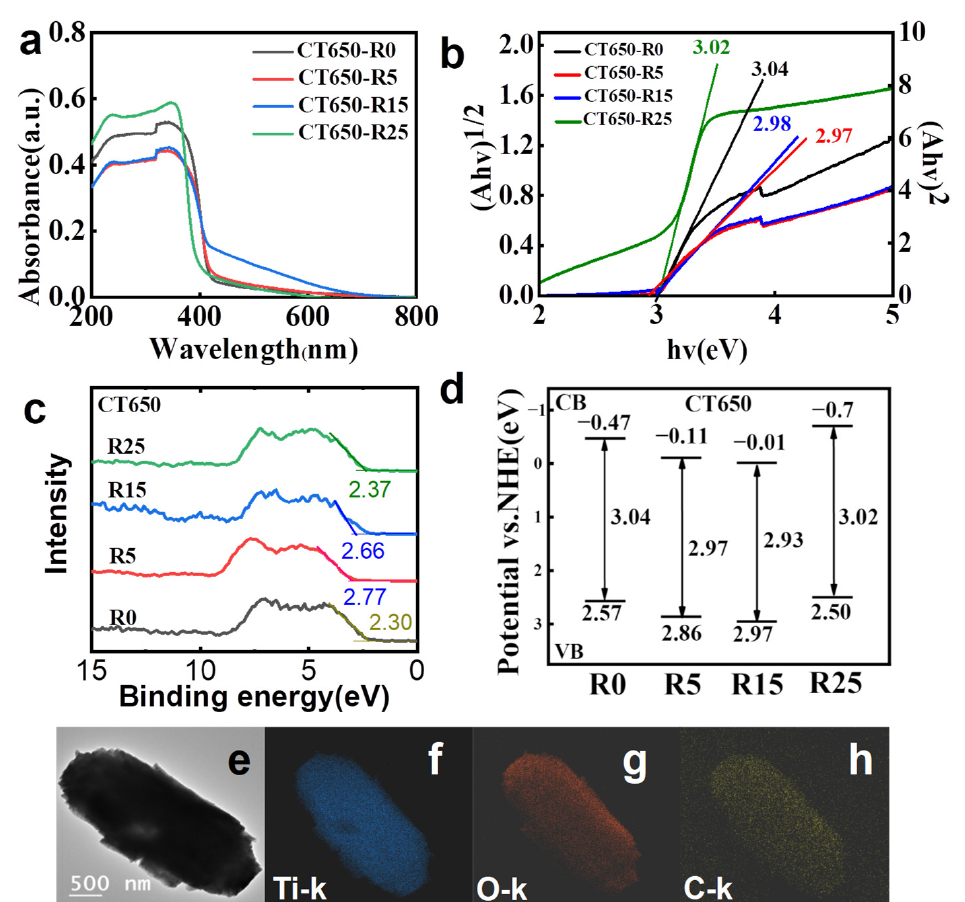
− 0.47, − 0.11, − 0.01 and − 0.7 eV, by subtracting the E of the VB and CB of each sample.